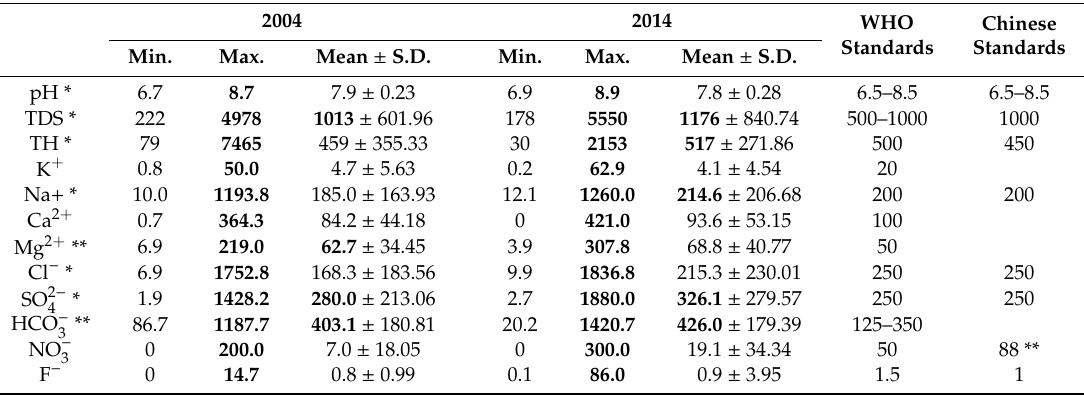
Table 1. Basic statistics of groundwater quality parameters in 2004 and 2014. 2004 2014